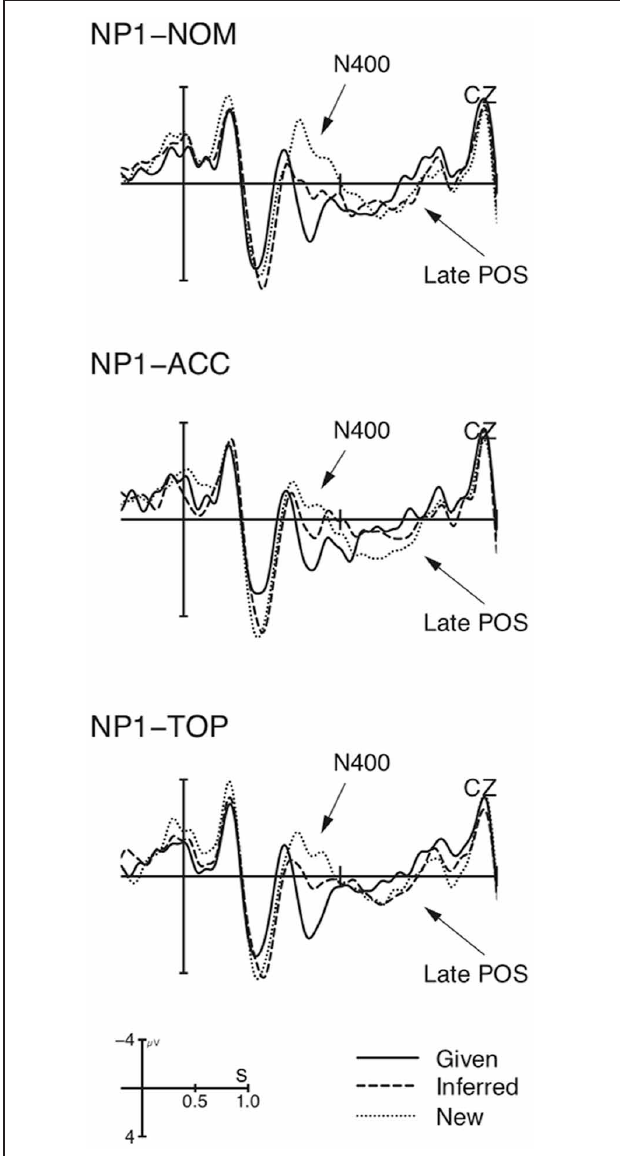
FIGURE 4 | Grand average ERPs ( n = 22) time-locked to NP1 in Experiment 2 (onset at the vertical bar) in the Given, Inferred, Contrastive New contexts. Negativity is plotted